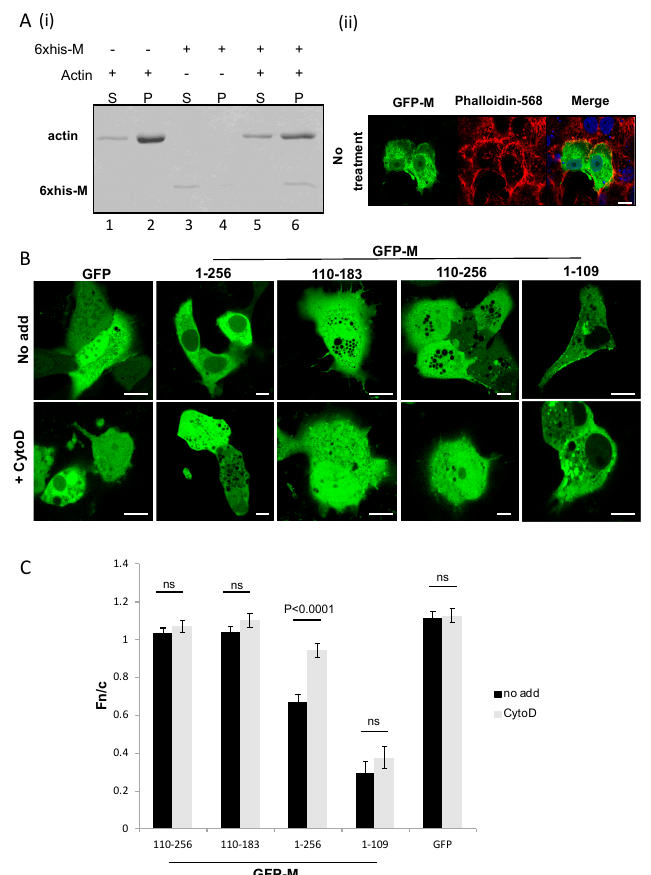
Figure 3. M binds polymerized actin. A ( i ) Recombinant purified M protein (6× His-M) was incubated with in vitro polymerized and monomeric actin, as described in the text. Samples were centrifuged to separate polymerized and monomeric actin. Supernatant (S) and pellet (P) fractions were analyzed with SDS-PAGE and visualized by Coomassie Brilliant Blue staining. The bands representing actin and RSV M are indicated. A ( ii ) A549 cells were cultured overnight and transfected to express full-length GFP-M (1–256). Transfected cells were left untreated and probed for visualization of the microfilament network (phalloidin-594). The colocalization of M and actin microfilaments is indicated in yellow (image labelled merge). Scale bars = 10 μ m. ( B ) Cos-7 cells were cultured overnight and transfected to express GFP, GFP-M (1–256), or deletion mutants GFP-M (110–183) and GFP-M (110–256). Transfected cells were left untreated (no add) or treated with cytochalasin D (+CytoD) and imaged live using confocal microscopy. Representative images are shown. Scale bars = 10 μ m. ( C ) Images such as those shown in ( B ) were analyzed by ImageJ to Fn/c. Data shown are mean ± SEM, n ≥ 15. Statistically significant differences between groups are shown, ns = non-significant.